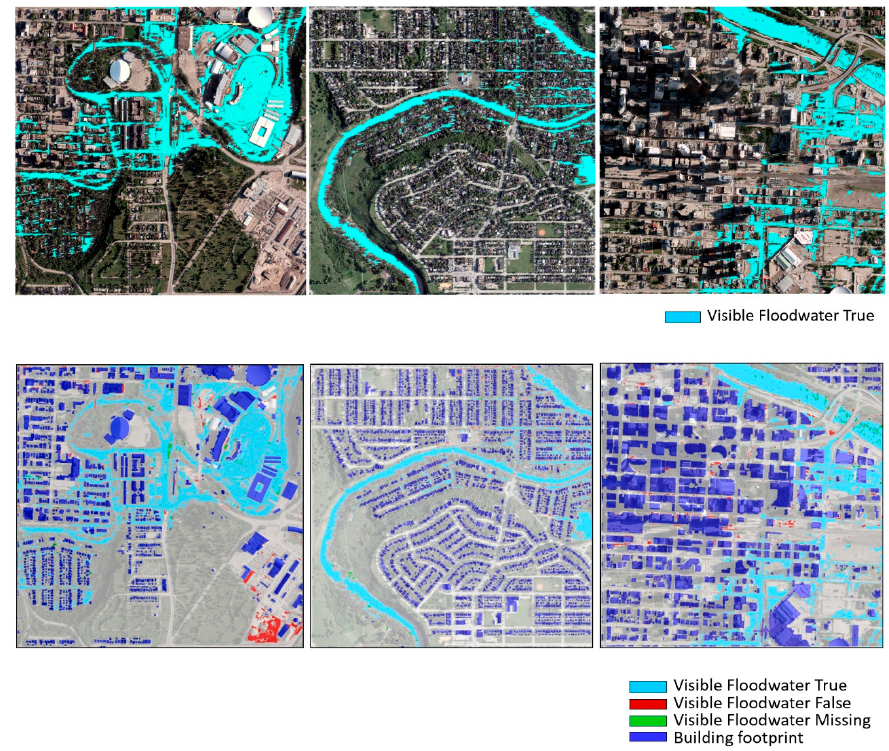
Figure 10. Maps of visible floodwater (upper) and the errors of visible floodwater extraction (lower) of site A (left), site B (middle), and site C (right).